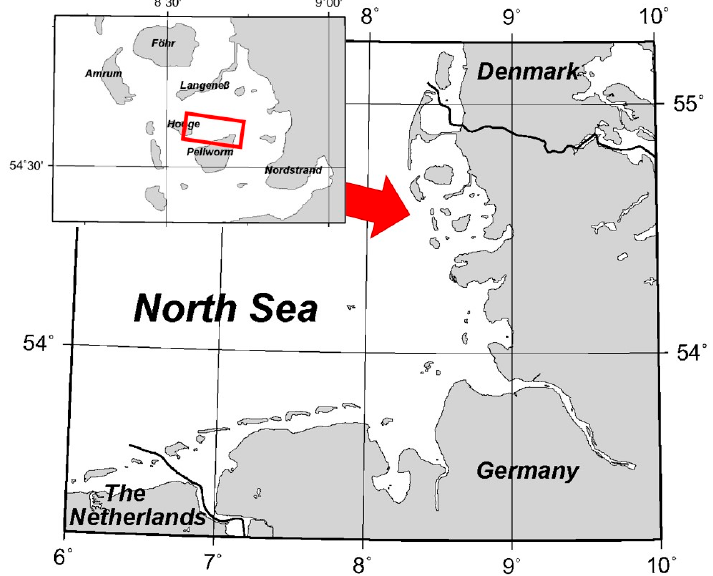
Figure 2. Area of interest on the German North Sea coast, north off Pellworm island, i.e., at the location of the former island of Strand. The red rectangle in the close-up on the upper left marks the location of the SAR image shown in Figure 3.